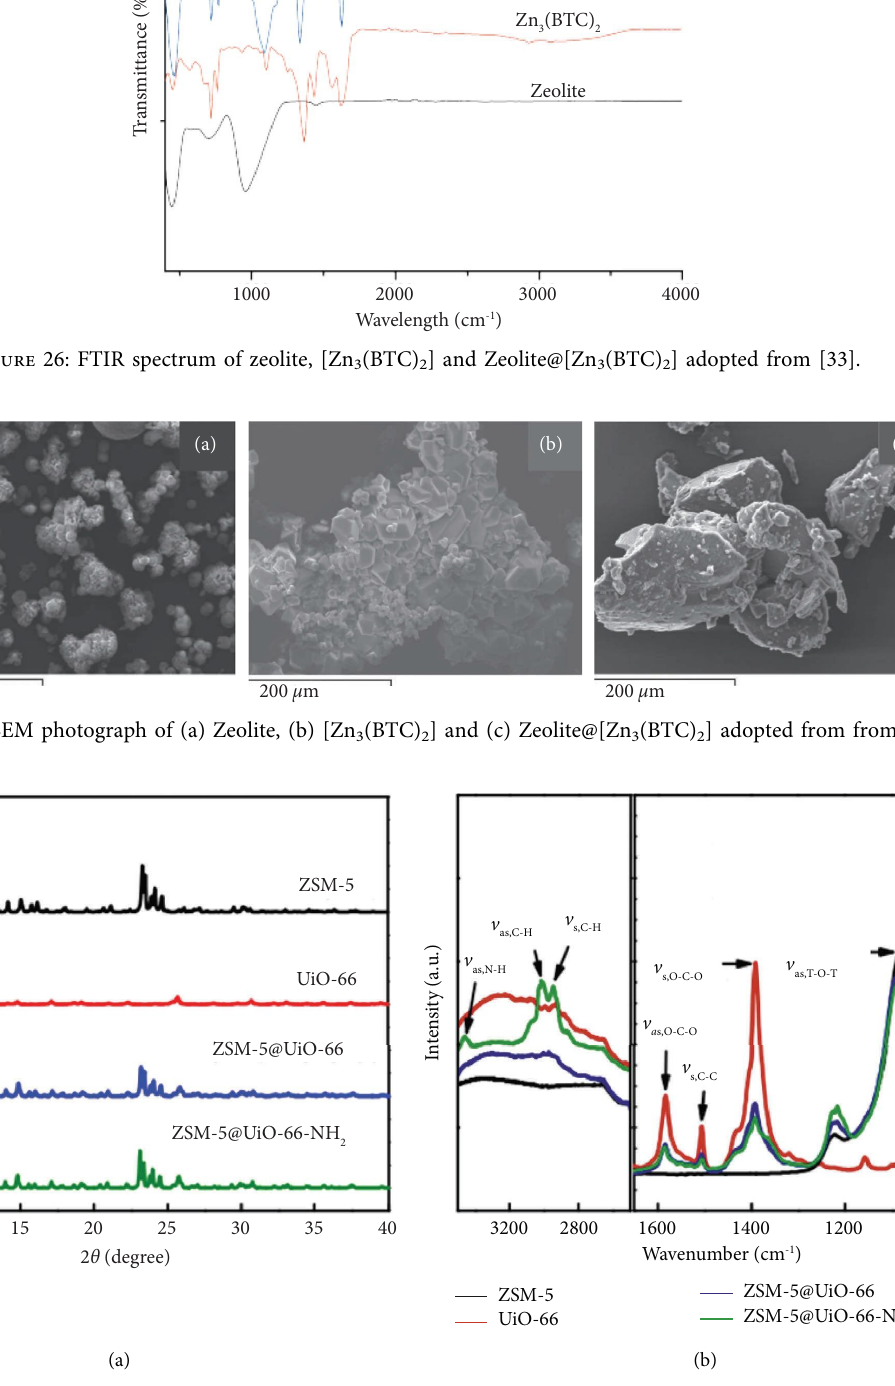
Figure 28: XRD patterns (a) and FTIR spectra (b) of ZSM-5, UiO-66, ZSM-5@UiO-66, and ZSM-5@UiO-66-NH